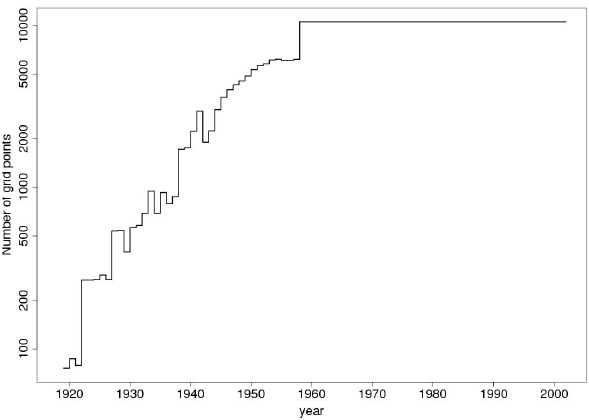
Fig. 1. Evolution of the number of available grid points in REC2 for late winter (JFM). Note that the scale is logarithmic.